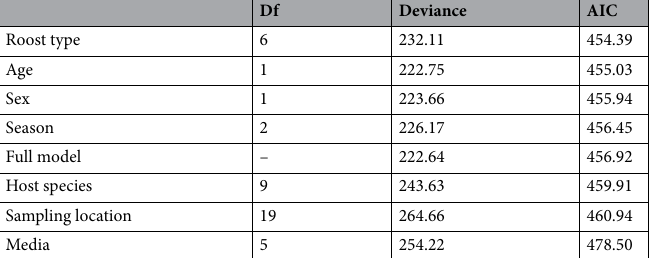
Table 2. Iterative single-term deletions were performed on a single GLM to determine the relative influence of each variable on the frequency of Pd -inhibiting isolates. The performance of each model was compared using the Akaike information criterion